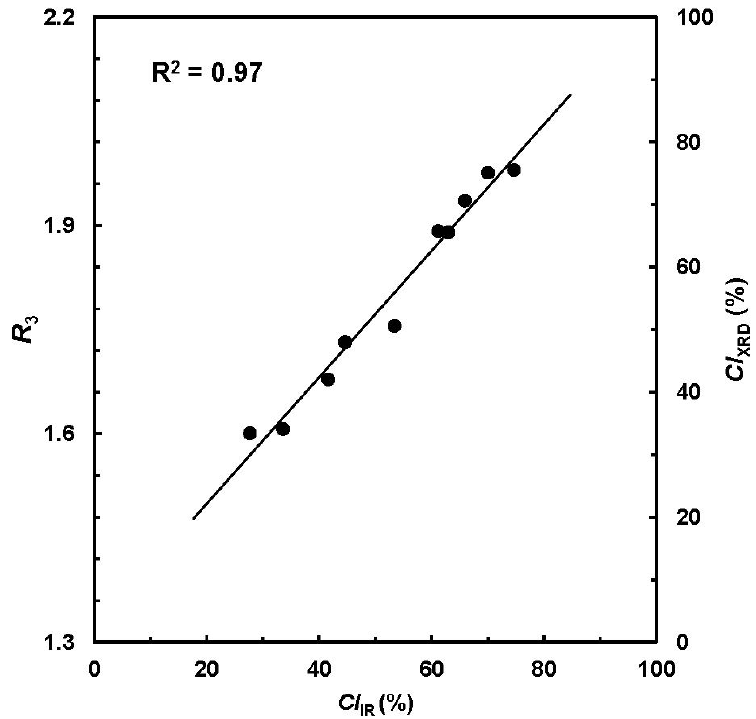
Figure 4. Plot of CI from ATR-FTIR procedure vs. CI IR measurement. (Reprinted with permission from [18]. Copyright 2012